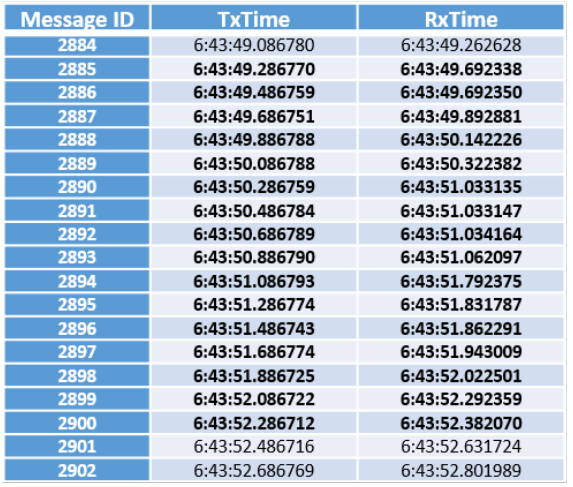
Table 1. Numerical sample of the E2E delay